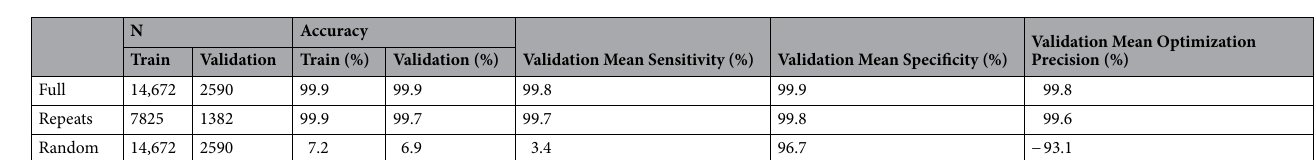
Table 2. Final training and validation accuracy, sensitivity, specificity, and optimization precision for full, partial, and randomized data sets. Note that the high specificity for the random model is a product of it repeating the same